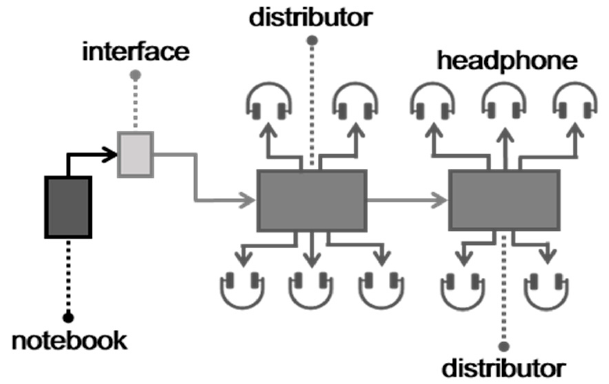
Figure 7. Equipment configuration diagram.